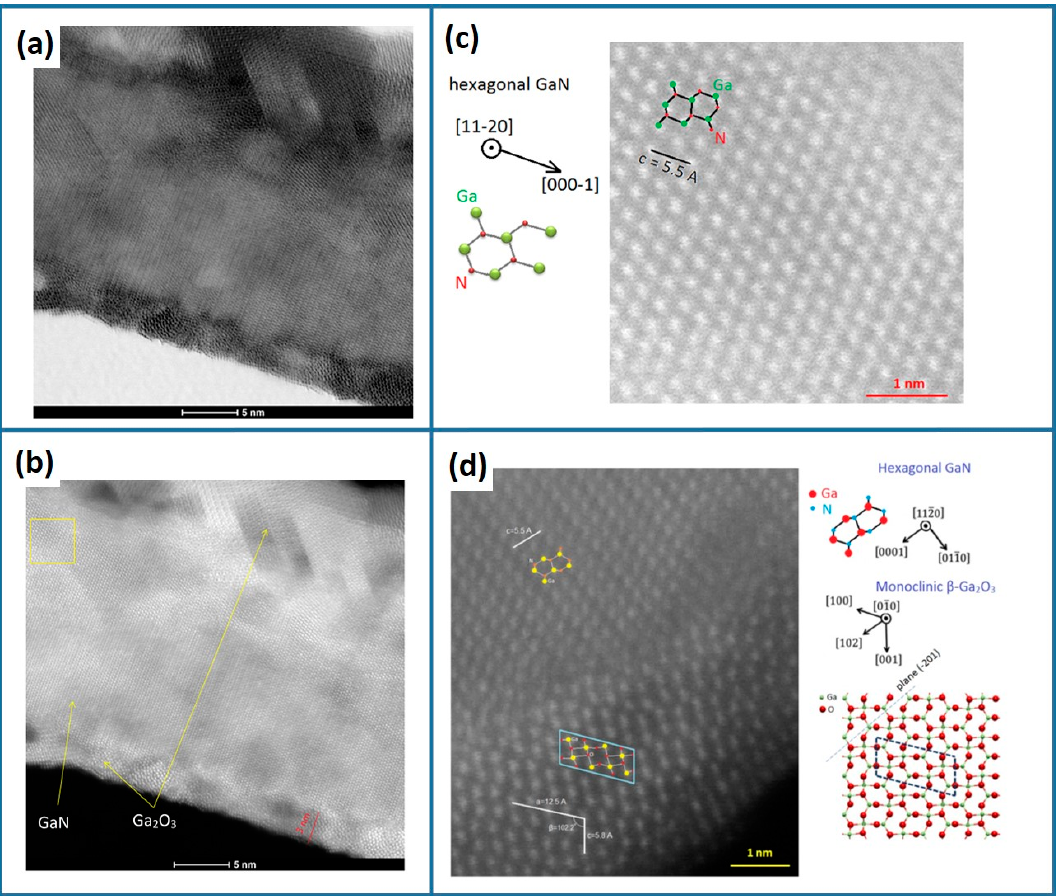
Figure 6. STEM images of GaN/Ga 2 O 3 NWs in ( a ) bright field mode; ( b ) dark field mode. ( c ) Magnification of the GaN-core. ( d ) Magnification at the GaN/Ga 2 O 3 interface. The β -Ga 2 O 3 structural representation is extracted from [63].